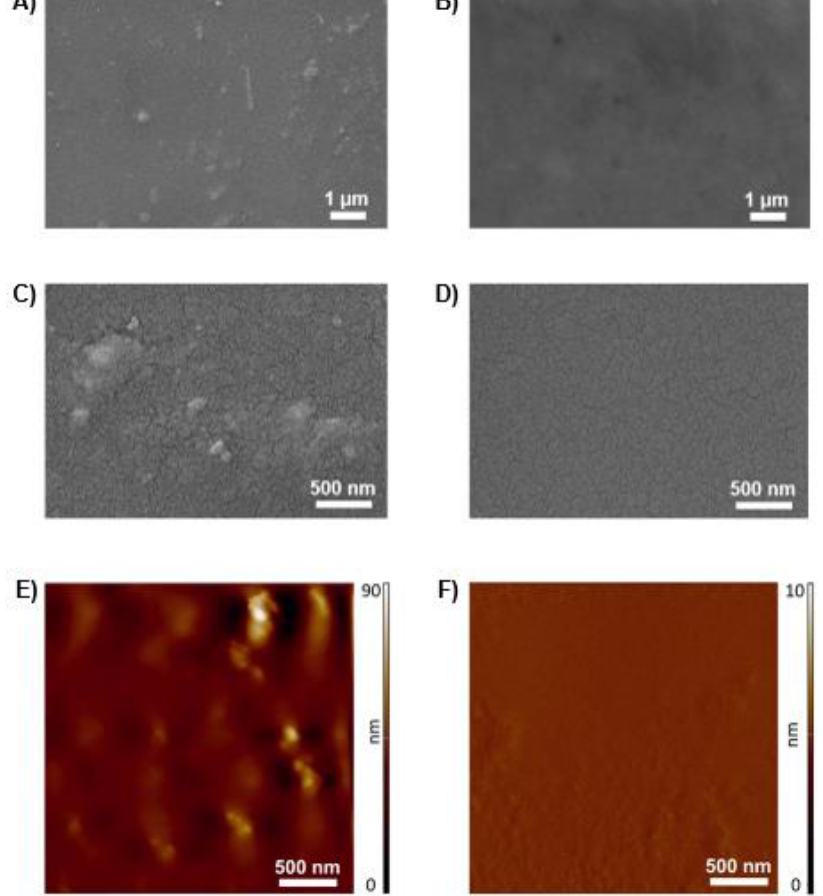
Figure 8. Morphological structure of the active layer surface of the organic photovoltaic cells. FE-SEM ( A – D ) and AFM topographical images ( E , F ) of the active material layers obtained from PT6buP + :C 60 -Ser (left column) and P[(T6buP + )- co -(T6F)] (right column).